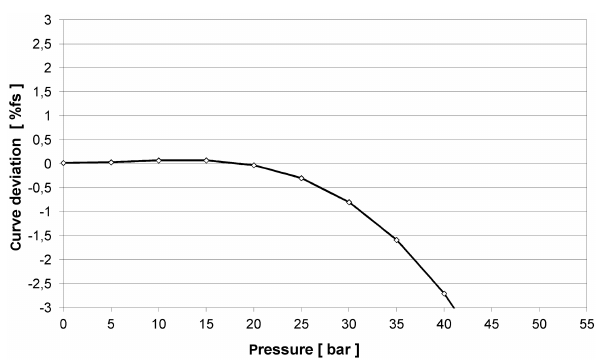
Figure 10. Characteristic curve deviation.